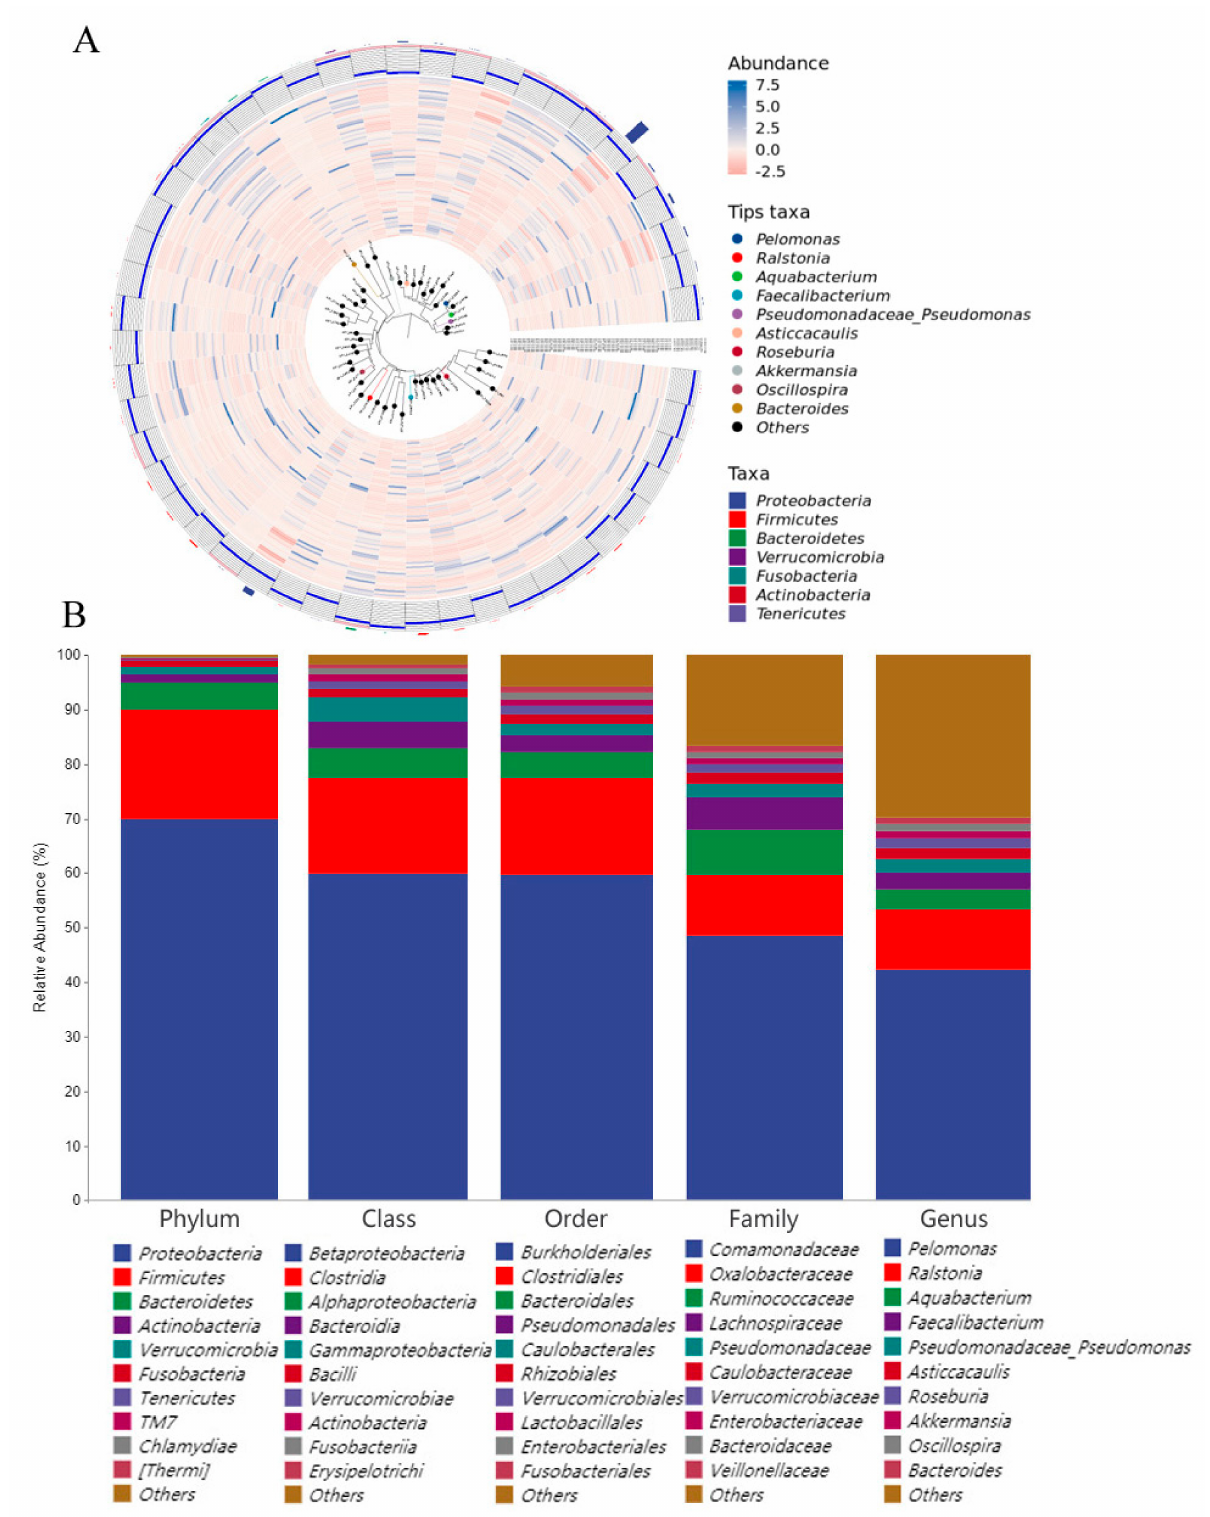
Figure 1. Composition of yolk microbiota and intestinal microbiota in the chicken embryo. ( A ) Phylo- genetic tree constructed from the taxa. According to the selected taxonomic level, OTU representative sequences (tips in the figure) and their connected branches are colored, and specific species can be selected for marking according to the needs. ( B ) The abundant microbes at each level (genus, family, order, class, and